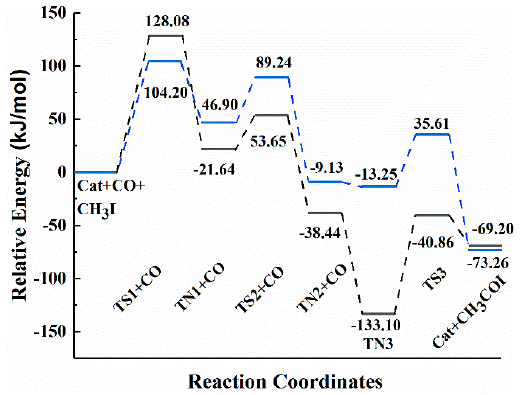
Figure 5. Potential energy diagram for the reaction pathway. Black line: The reaction barrier diagram of the Monsanto catalyst catalyzing methanol carbonylation to acetic acid. Blue line: The reaction barrier diagram of Rh(I) / Ru(III) bimetallic catalyst catalyzing methanol carbonylation to acetic acid.